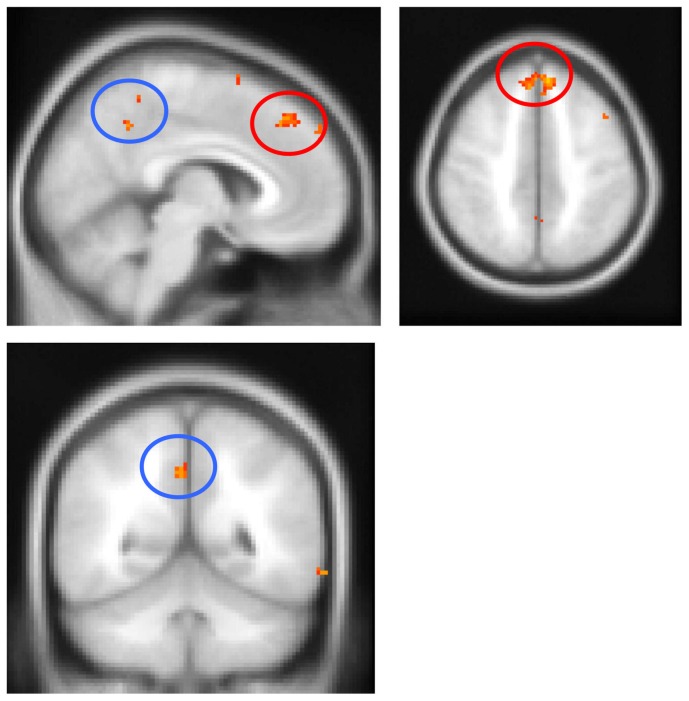
Voxel-based morphometry analysis with the apraxia score as a covariate in CBS patients.The degree of apraxia (as reflected in an increased apraxia score) correlated with atrophy of the medial frontal cortex (red circles) and the precuneus/posterior cingulate (blue circles). Clusters are overlaid on the Montreal Neurological Institute standard brain (t>2.41). Colored voxels show regions that were significant in the analyses for P<0.001 uncorrected and a cluster threshold of 20 contiguous voxels. Circled areas indicate: red  =  medial frontal cortex; blue  =  precuneus/posterior cingulate.